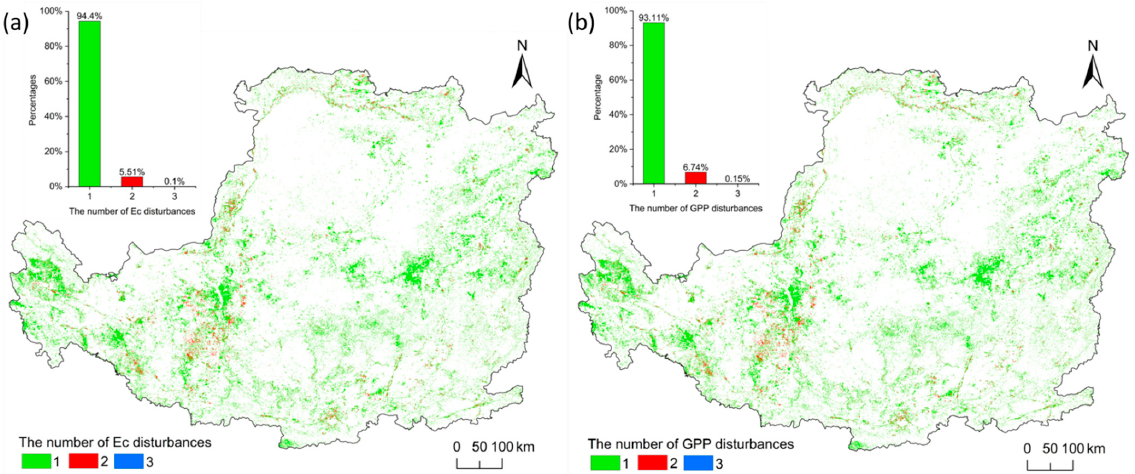
Figure 4. Spatial distribution of the number of disturbances in the CLP and the percentage of different number of disturbances: ( a ) Ec; ( b ) GPP. In both graphs and maps, the green part represents the proportion and spatial distribution of pixels that experienced one breakpoint; the red part represents the pixels that experienced two breakpoints; and the blue part represents the pixels that experienced three breakpoints.